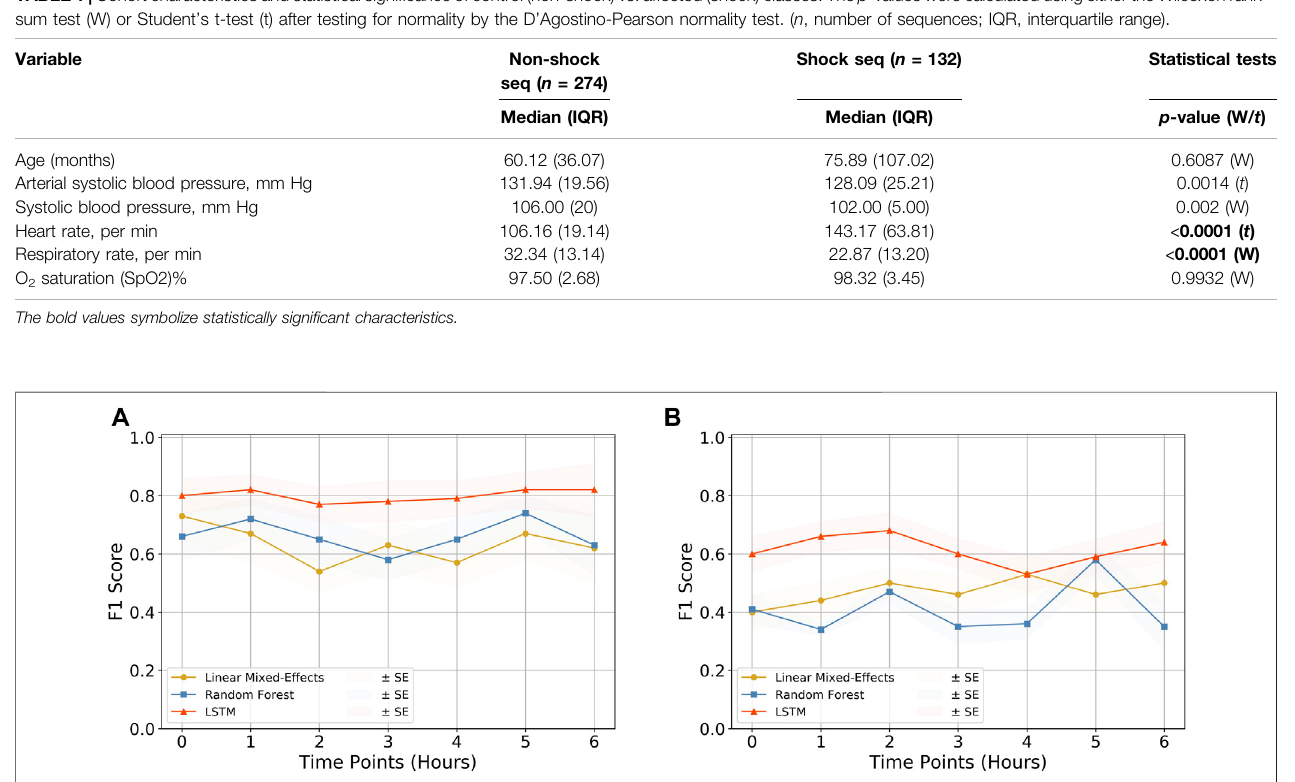
FIGURE 3| Quality assessmentof models. The F1 scorecomparison for the three models (i.e., Linear Mixed-Effectsmodel, Random Forest, and LSTM) tested on (A) CPD and heart rate and (B) CPD parameter only. It can be observed that the LSTM model outperforms the other two models in both cases, making it the primary choice of this research. The rest of the comparison plots are depicted in Supplementary Figure S1